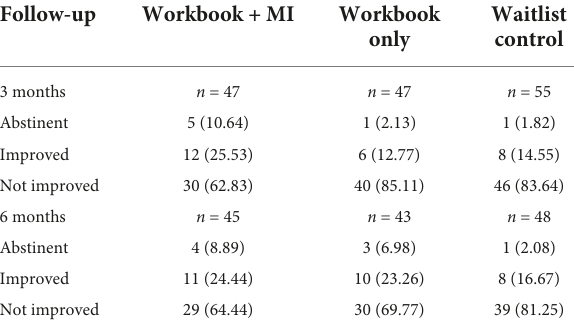
TABLE 4 Classification of outcome based on days of cannabis use n